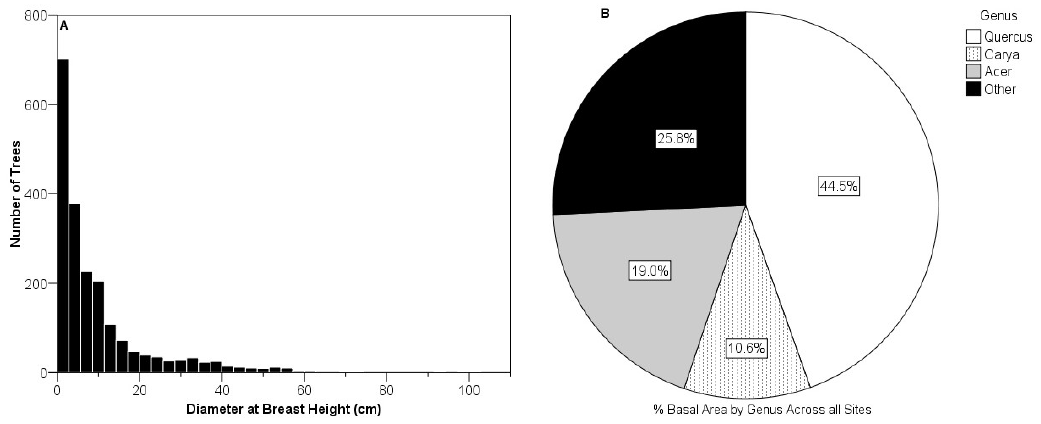
Figure 3. Aggregate Overstory Composition Results: 2,027 woody plant stems (trees and shrubs) were encountered in the 12 study plots established in forest edge zones. One plot was established in each of the 12 protected areas throughout the study region. ( A ) Frequency distribution of measures of diameter at breast height (DBH); ( B ) Percentage of woody basal area by genus across all woody plants; ( C ) Percentage of woody biomass by genus across all woody plants; ( D ) Percentage of woody stem counts by genus across all woody